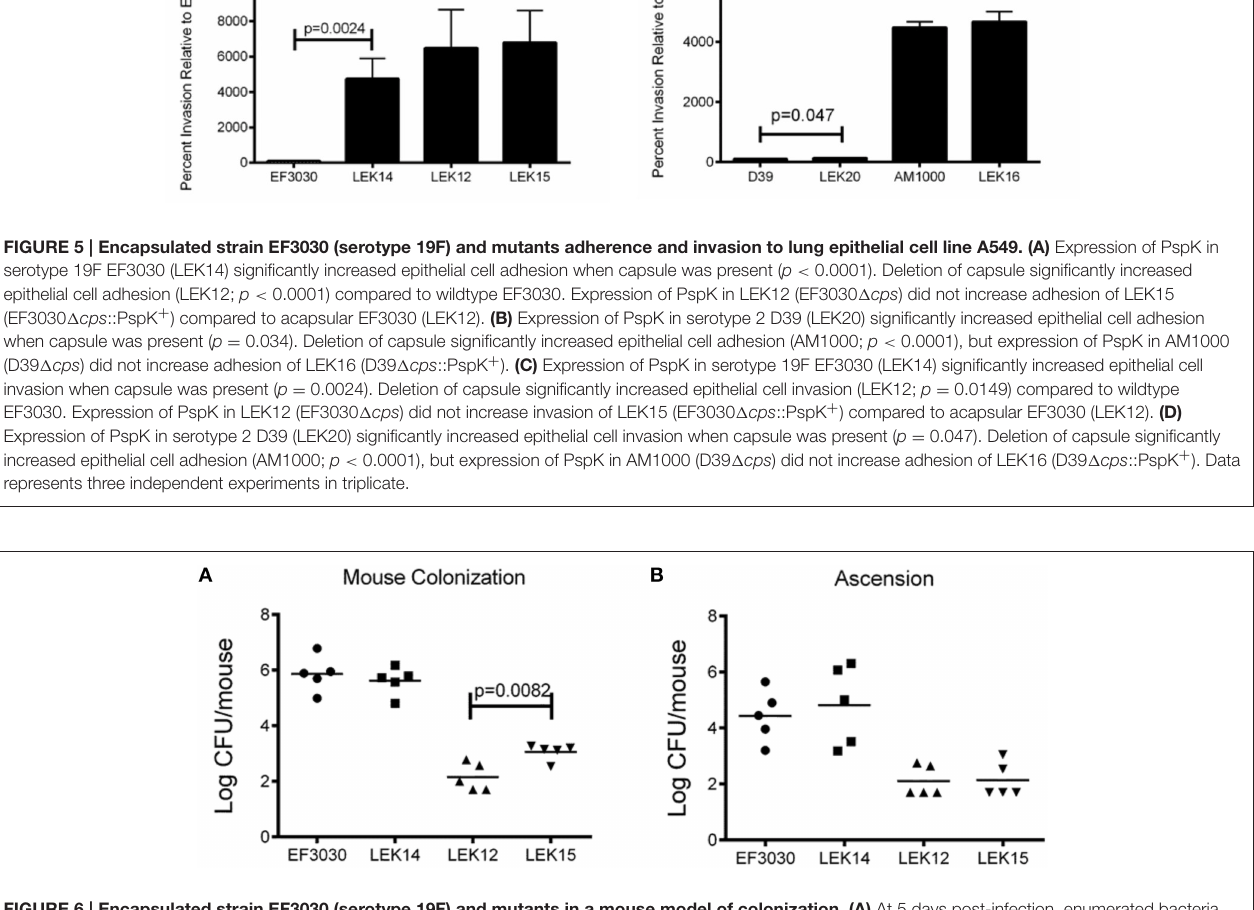
FIGURE 6 | Encapsulated strain EF3030 (serotype 19F) and mutants in a mouse model of colonization. (A) At 5 days post-infection, enumerated bacteria recovered from the mouse nasopharynx did not significantly increase when encapsulated EF3030 expressed PspK. EF3030 capsule mutant, LEK12, showed significantly more colonization when PspK was expressed (LEK15; p = 0.0082). (B) Collected bullae from colonized mice showed no significant difference in middle ear ascension when PspK was expressed independent of capsule status. Mean CFU/mouse indicated by horizontal bar on